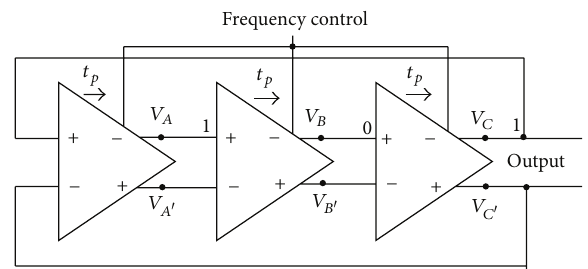
Figure 1: Block diagram of the 3-stage ring-VCO.